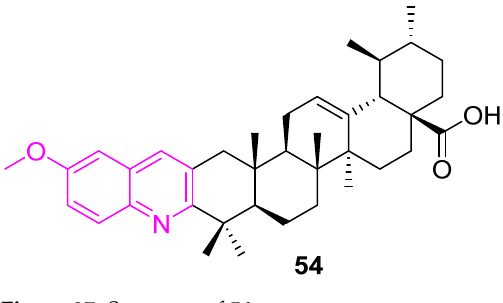
Figure 37. Structure of 54 .